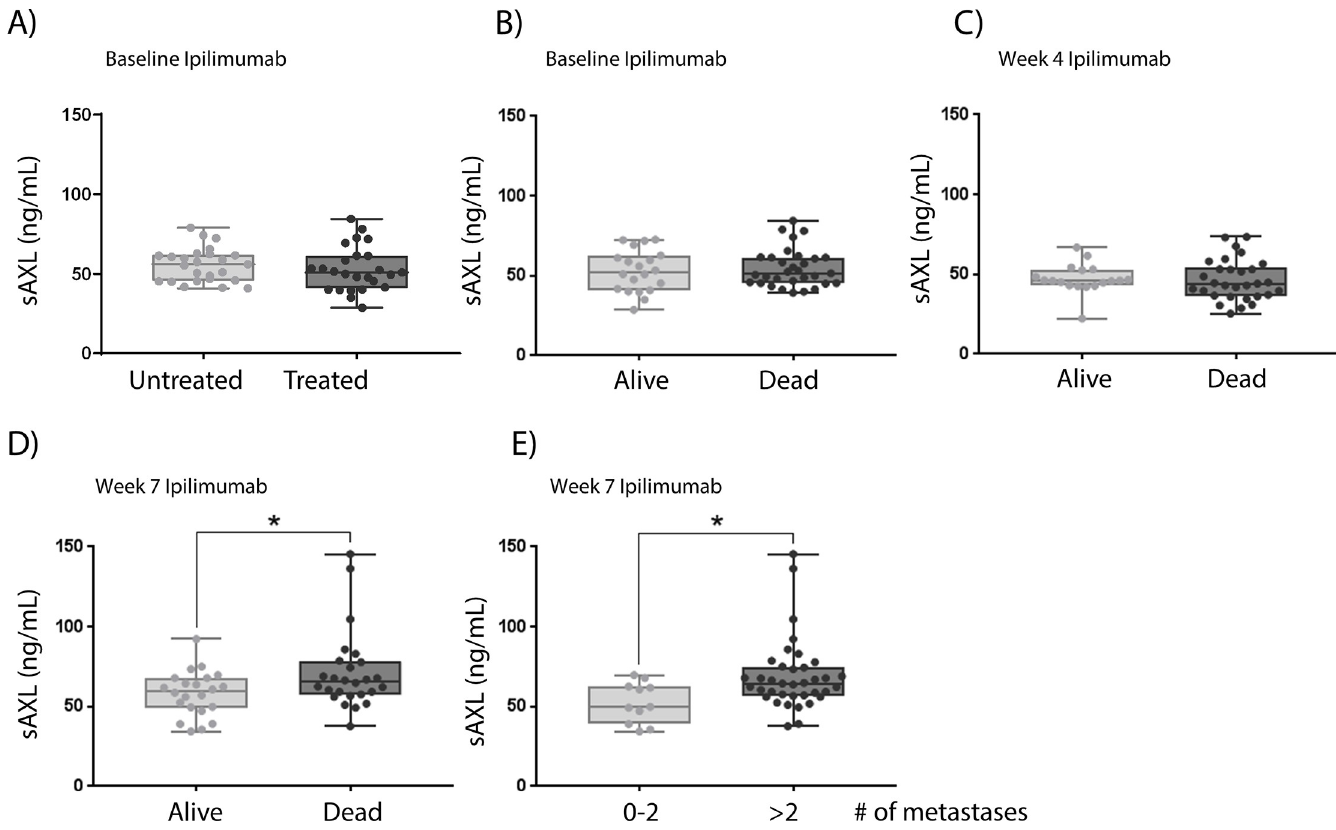
Fig 5. sAXL levels are increased in patients with shorter two-year survival after seven weeks of ipilimumab treatment. A) sAXL levels measured by ELISA in plasma samples in previously treated versus untreated patients at the start of ipilimumab treatment. sAXL levels in serum samples from stage IV patient harvested B) before the start, C) at week 4 or D) at week 7 of ipilimumab treatment grouped according to survival after two years. E) sAXL levels in serum harvested at week 7 of ipilimumab treatment related to number of metastases. sAXL levels were determined by ELISA and run in technical duplicates. The figures are displayed as box and whiskers plot ± range, where each point represents one patient. � = p value �